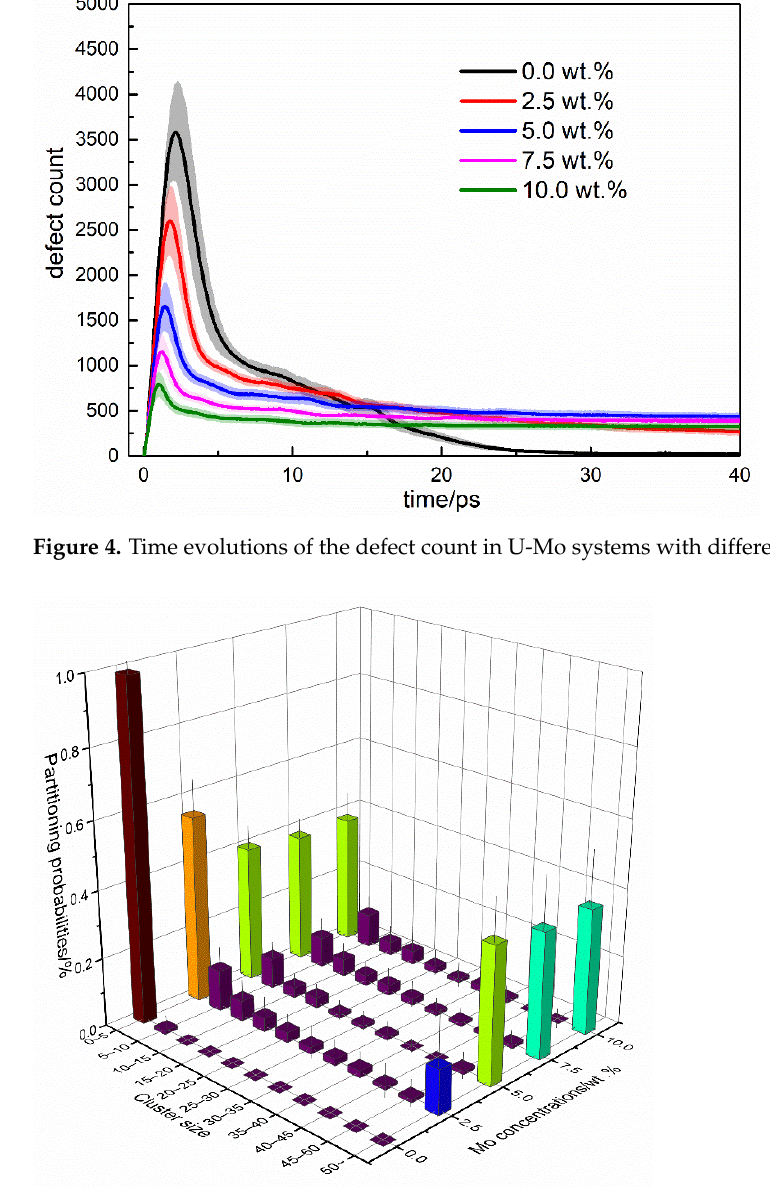
Figure 5. Size distributions of residual defect clusters versus Mo contents.